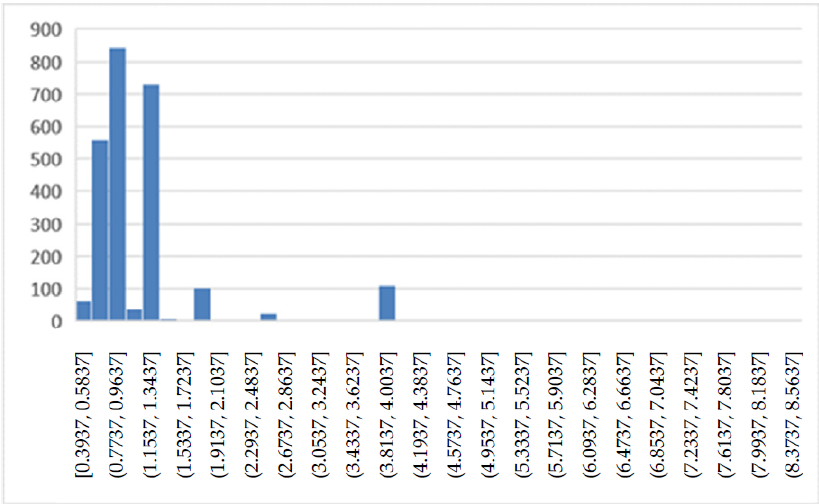
Figure 4. DRG relative weight (2018, 2019).